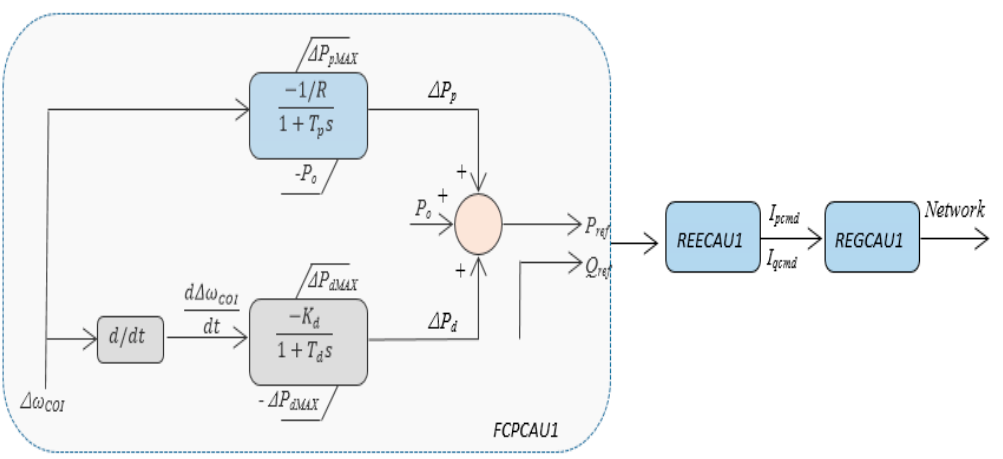
(10) Figure 3. Frequency of center of inertia (FCOI) wind inertia control scheme. Based on the proposed scheme, a novel generic model of wind inertial controller FCPCAU1 is developed. The structure of FCPCAU1 is presented in Figure 4. FCPCAU1 is written in FORTRAN. PSS/E Environment Manager is used to compile code and create a dynamic linked library (DLL) [29]. The application of available wind generator and wind electrical PSS/E models combined with a user-